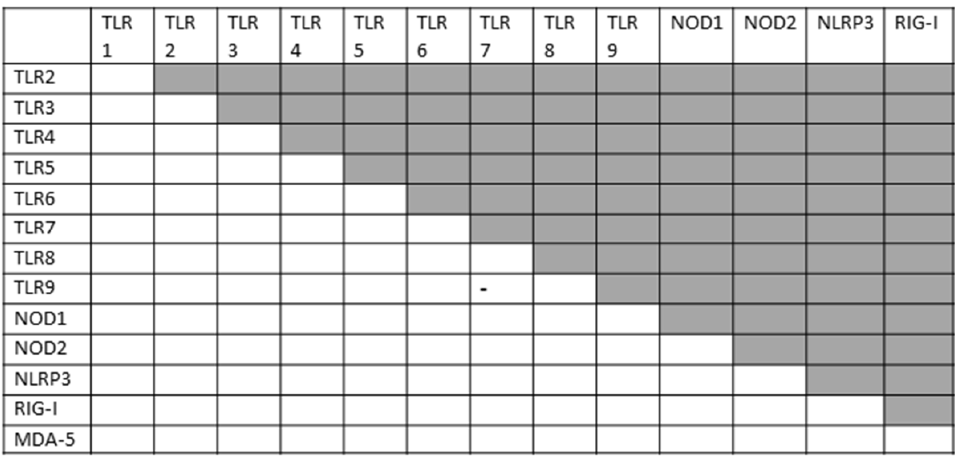
Figure 9. Predicted synergisms (+) and antagonisms ( − ) resulting from adenovirus-vectored SARS-CoV-2 spike protein vaccine activation of innate receptors resulting from mapping Figure 3 (literature review of innate receptor activation) onto the template provided by Figure 2 (summary of known innate receptor synergisms and antagonisms).